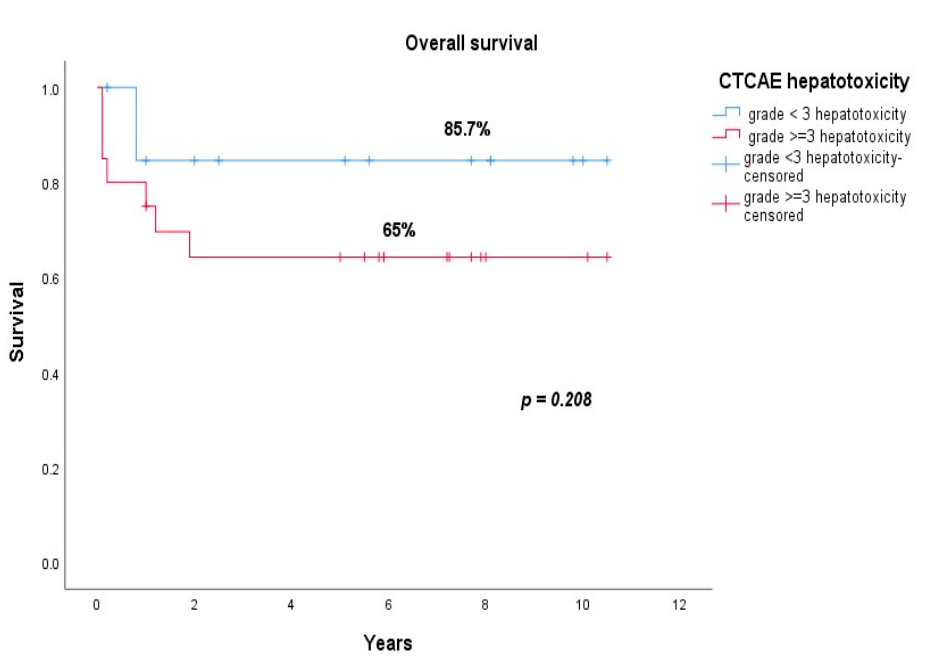
Table 4. Multivariate Cox regression analysis of the impact of asparaginase hypersensitivity on out- come.